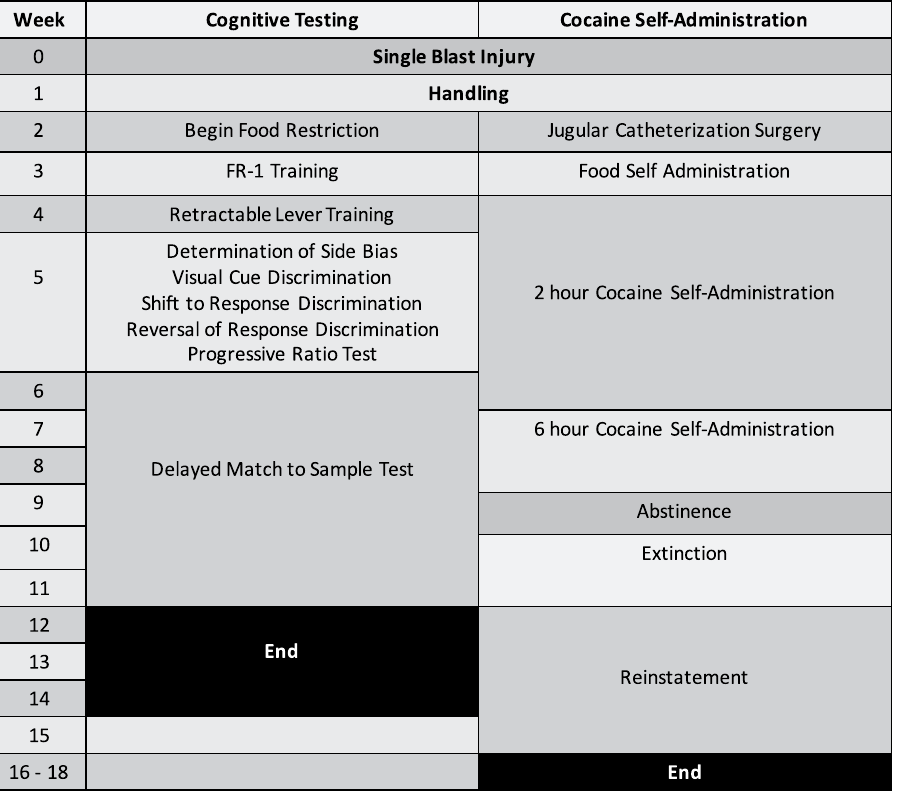
Figure 1. Timeline illustrating the sequence of behavioral tests in experiments one and